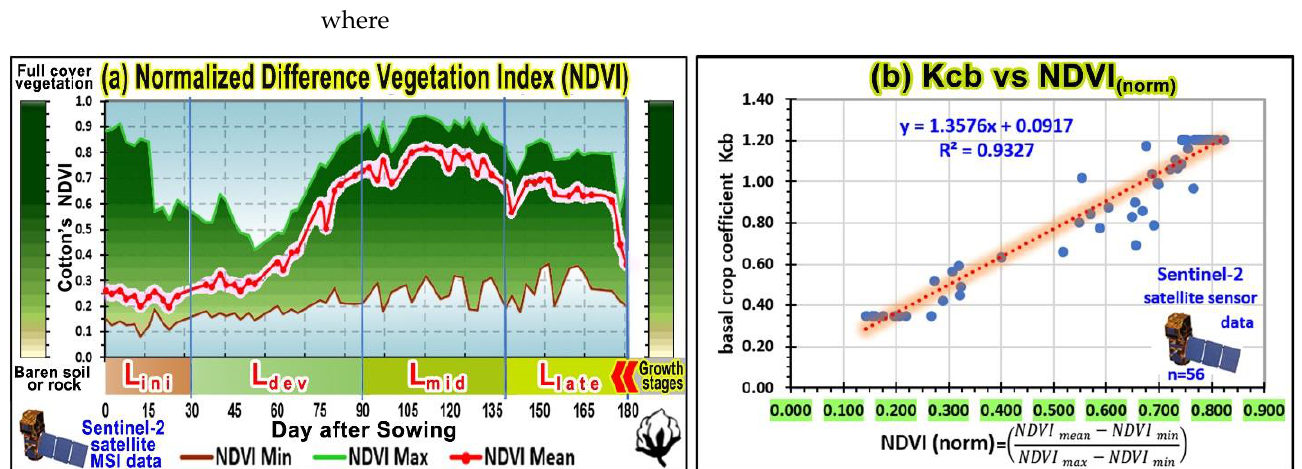
Figure 4. ( a ) The NDVI vegetation index for the 4 cotton growth stages (using Sentinel-2 satellite MSI data) and ( b ) a diagram of the basal crop coefficient ( K cb ) vs. NDVI (norm) of cotton’s growth spatial patterns values (using NDVI vegetation indexes derived from 56 Sentinel-2 satellite images).